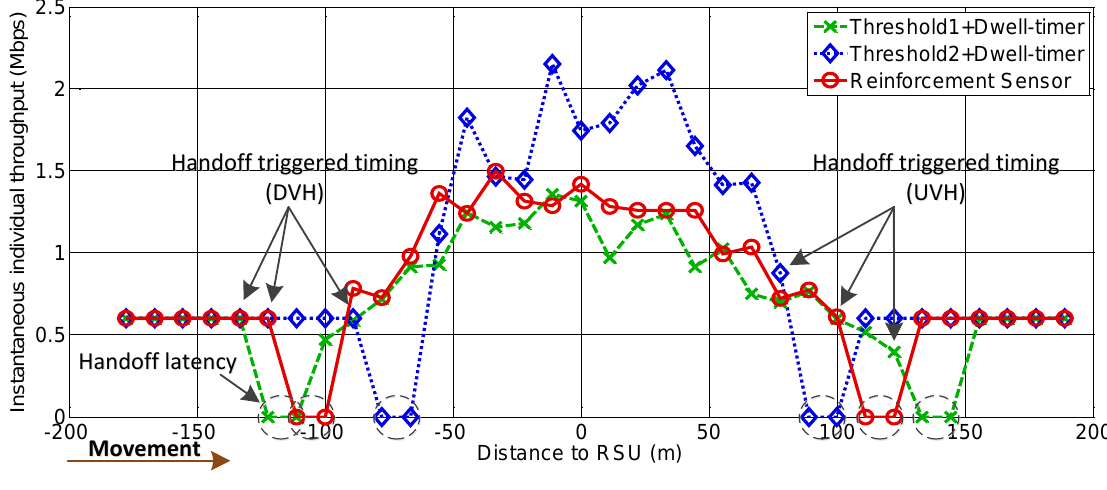
Figure 9. Distribution of individual throughput vs. distance to RSU (arrival rate = 0.4 veh/s).